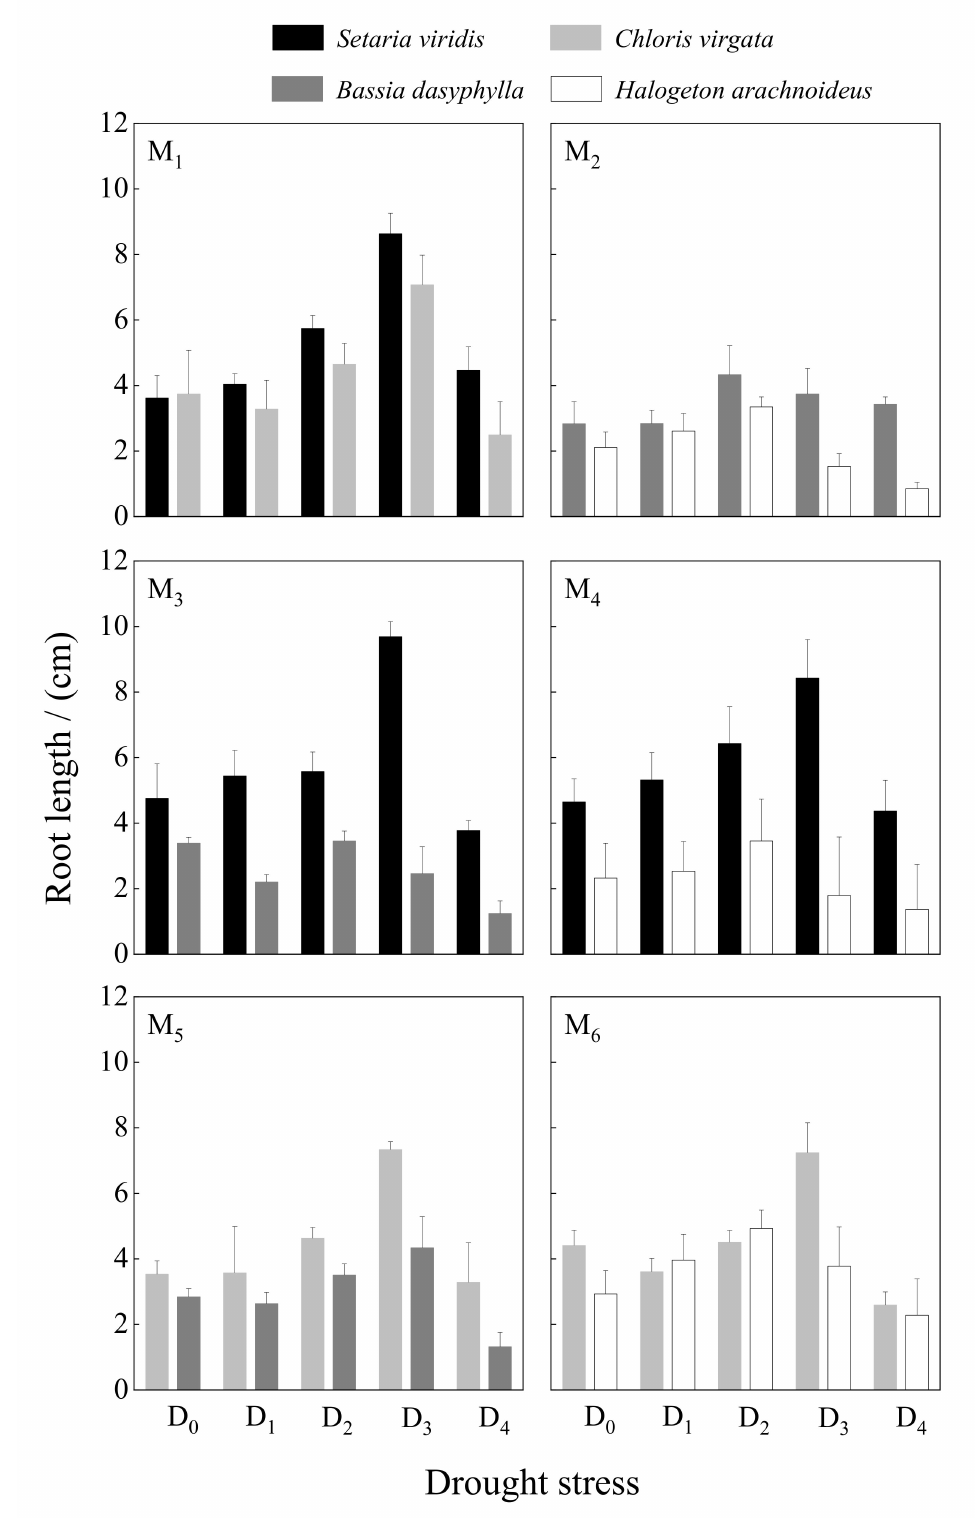
Figure 5. Response of root length of four annual desert plants to the interaction of drought and mixed sowing (D0–D4 represents five drought stress gradients and D0–D4 represents PEG-6000 solution with different concentrations simulating different drought stress gradients, respectively: control 0% (D0), mild drought 2% (D1), moderate drought 5% (D2), moderate and high drought 10% (D3), and severe drought 15%